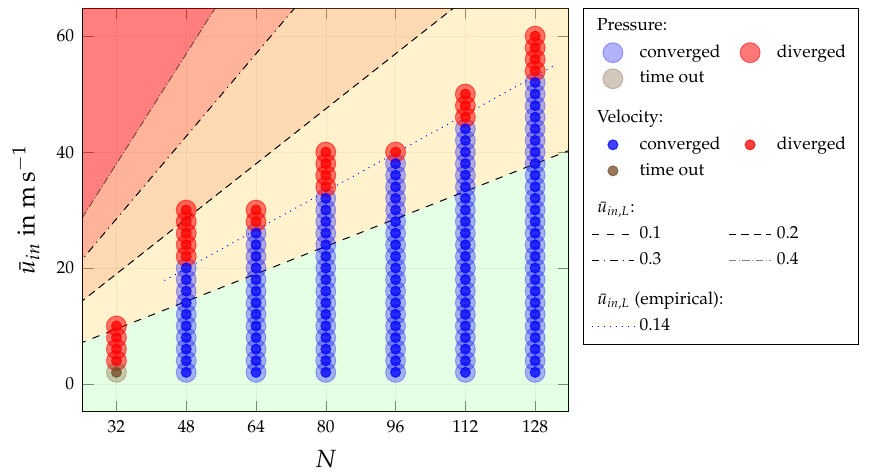
Figure 7. Stability map for pressure and velocity convergence in particle-free flow. Contour lines show stability-relevant and empirically determined velocities at lattice scale. Background colouring indicates distance to theoretical LBM stability limits (green to